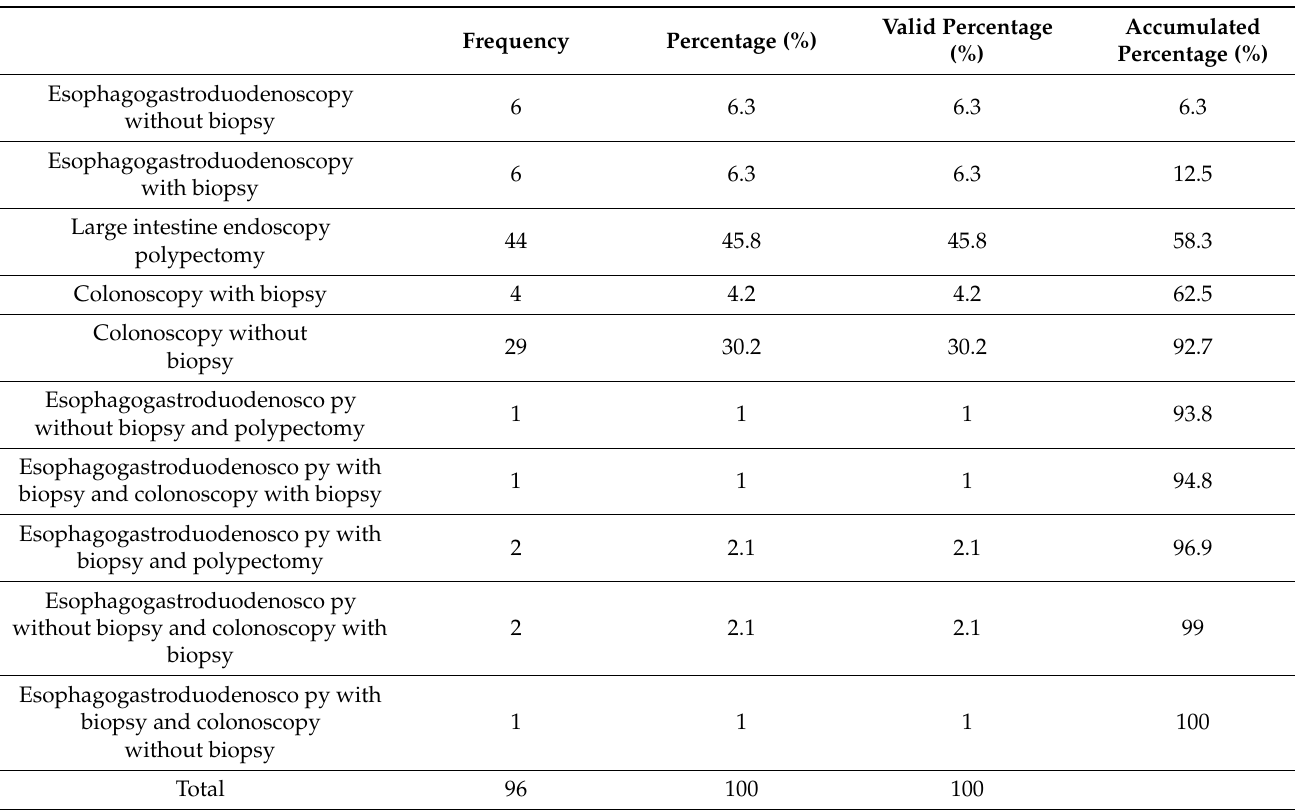
Table 2. Includes the therapeutic procedures of the patients